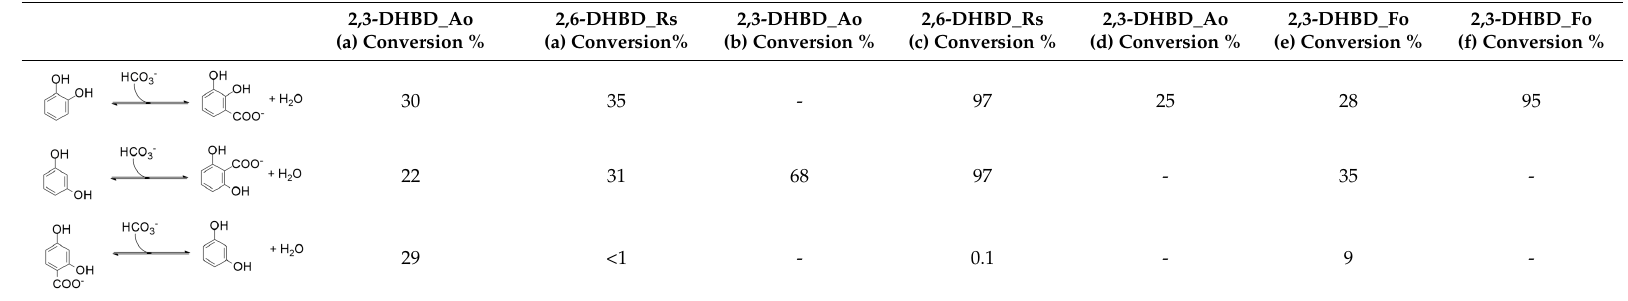
Table 7. Comparison of substrate conversion obtained by using 2,6-DHBD_Rs, 2,3-DHBD_Ao, 2,3-DHBD_Fo, and SAD_Tm enzymes in ortho -carboxylation reactions of catechol and resorcinol.